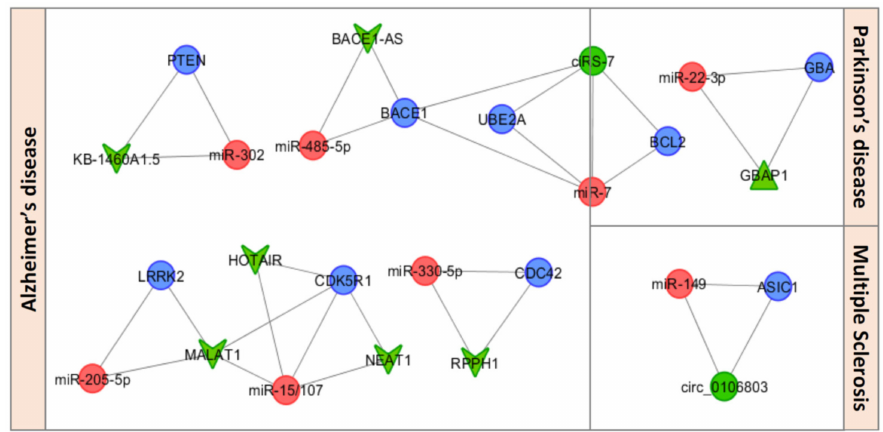
Figure 2. Neuroinflammatory-related ceRNETs involved in NDDs. miRNAs, competitor mRNAs and ceRNAs are represented in red, blue, and green respectively (with di ff erent shapes for each ceRNA class: circular shape for circRNAs, triangular shape for pseudogenes, and V shape for lncRNAs). The networks were visualized using Cytoscape